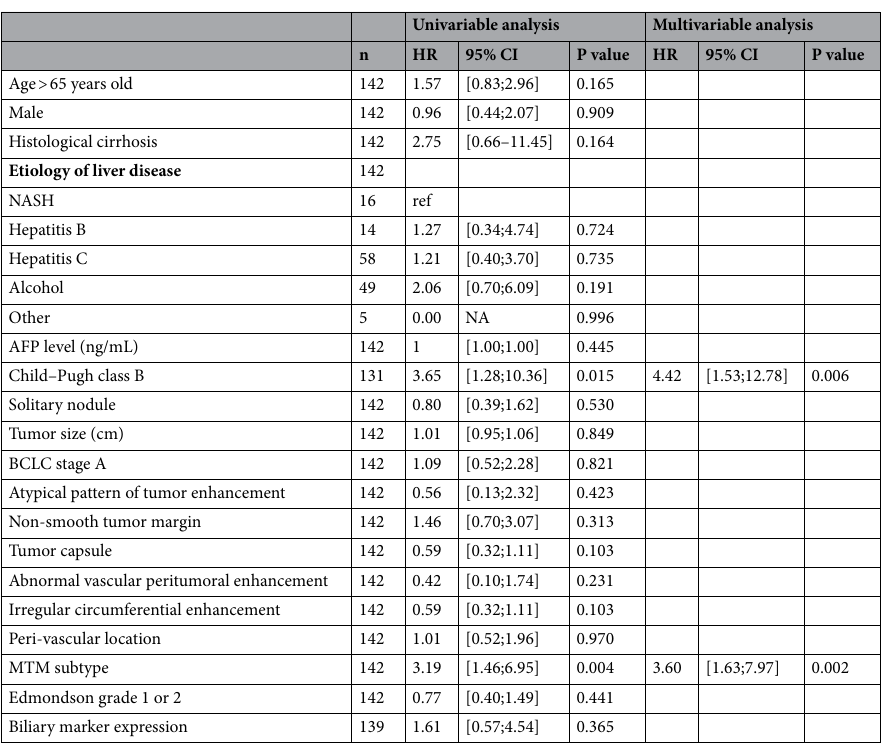
Table 5. Univariable and multivariable analysis of characteristics associated with overall survival in patient with non-infiltrative HCC smaller than 3 cm. NASH, non-alcoholic steatohepatitis; AFP, alphafoetoprotein level; BCLC, Barcelona Clinic Liver Classification; HR, hazard ratio; MTM, macrotrabecular